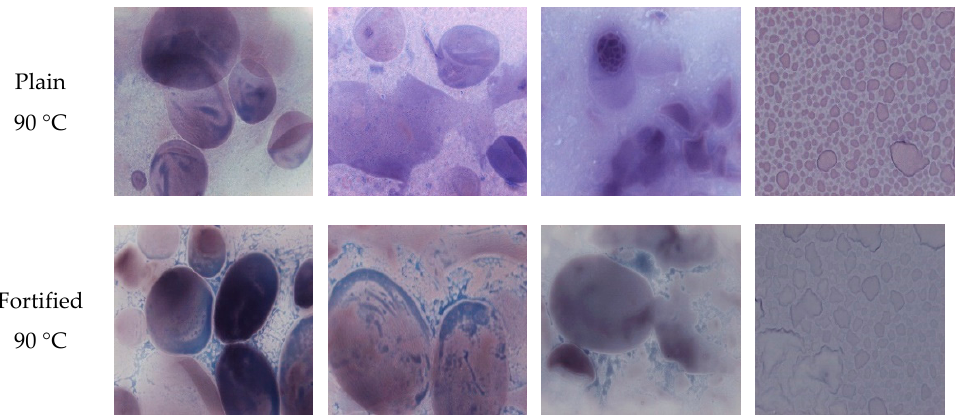
Figure 3. Light microscopy pictures of pastes of native starch and oxidised starches having different degrees of substitution, prepared at different temperatures. LM picture of pastes obtained from oxidised (plain) and fortified (oxidised, containing copper ions) starches with different substitution degrees heated at 65 and 90 °C.